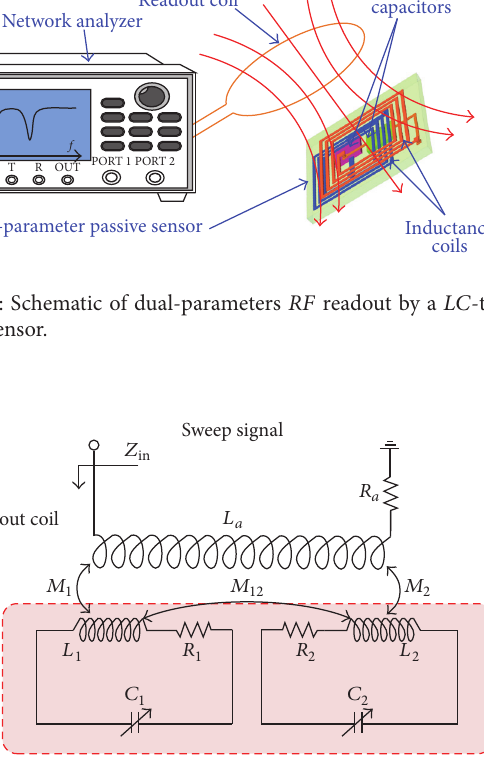
Figure 2: Lumped circuit model of the passive dual-parameter sensor